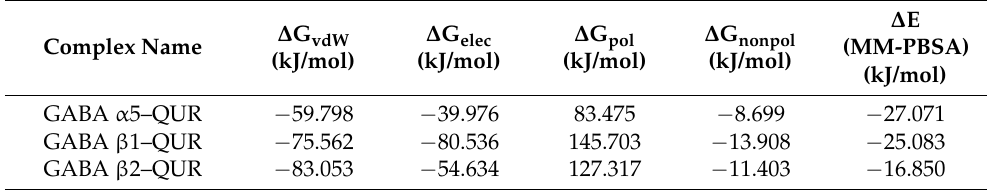
Table 8. The calculated binding energies of AA and QUR/targets (GABA( α 5), GABA( β 1), and GABA( β 2))